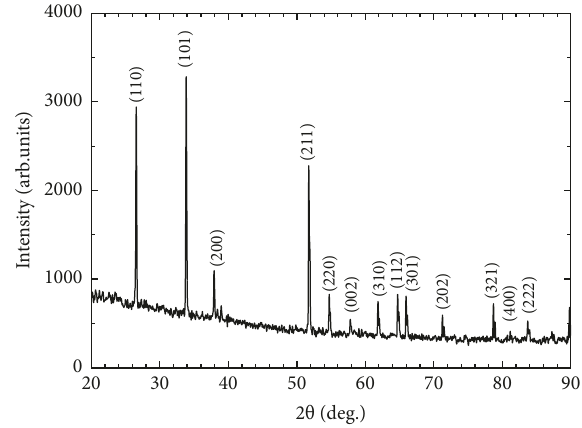
Figure 1: XRD spectra of the SnO